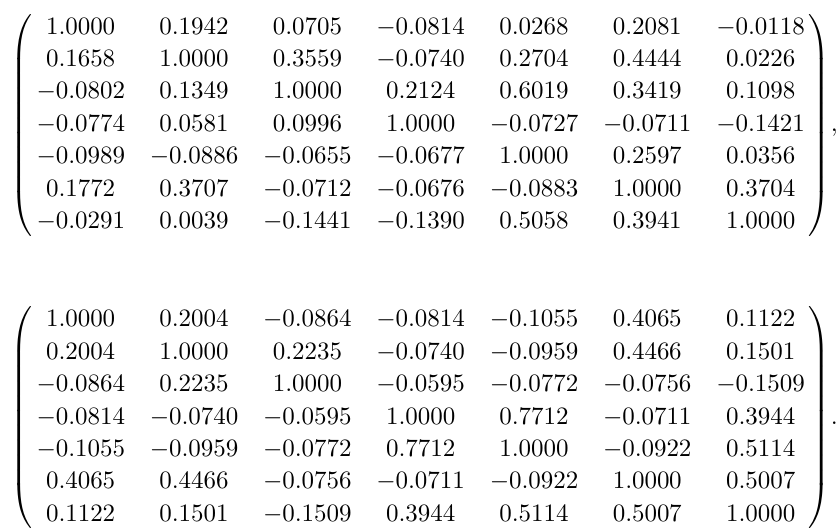
of the macroeconomic event adverse for debtors rated at AAA and AA is as the following: Table 7 characterizes the support of ~ p ð i Þ . For a threshold (cid:15) , N denotes the number of out- comes whose probabilities exceed (cid:15) and Pr stands for the sum of these probabilities. (Concep- tually, Pr is the probability that at least one of the outcomes occurs.) This pattern of concentration resembles closely its counterpart reported for S = 1. Consequently, the distribu- tion of tendency variables seems to be not affected by the diversification mechanism based on industry-specific q . This is an intuitively plausible conclusion given that the part of the model i , s defining tendency variables remains unchanged. Correlations R ( i ) are given next. The first of the matrices contains R ð 1 Þ below the main diagonal and R ð 2 Þ above it. i ; j i ; j